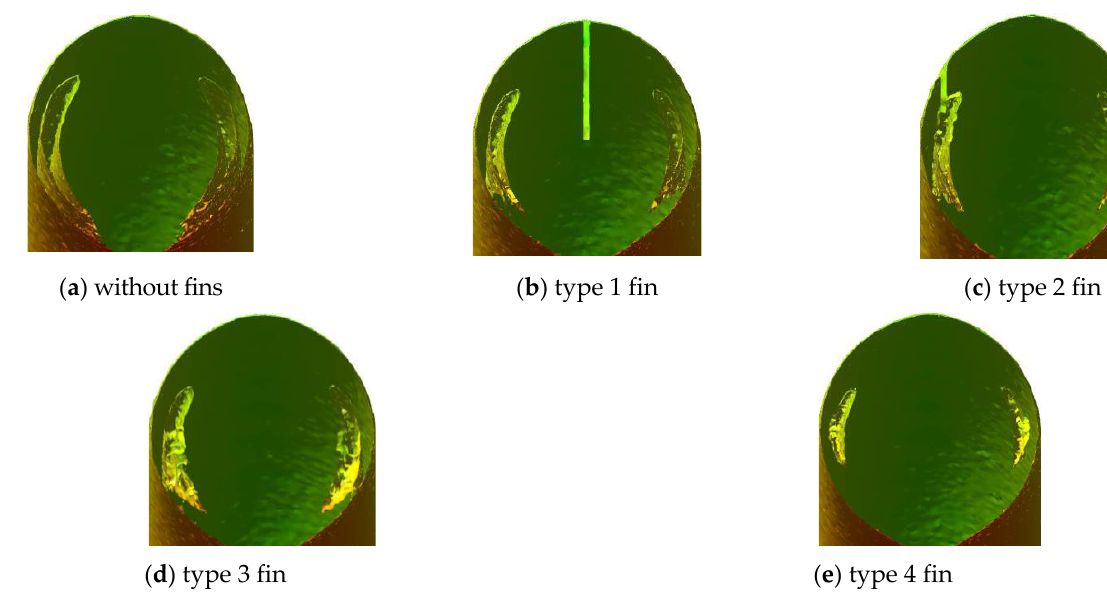
Figure 8. Vortex formation in section 3 of an inlet pipe.